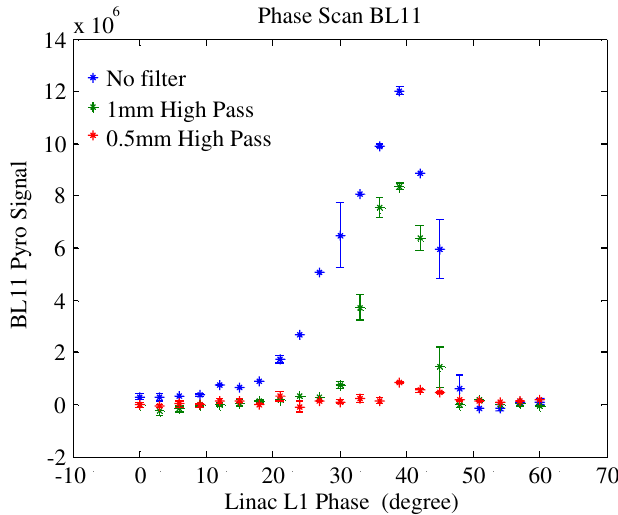
FIG. 25. (Color) Response of pyroelectric detectors (arbitrary scale) as a function of the L1S rf phase (rf section before BC1). A phase of zero is on-crest and a positive phase compresses the bunch length. The plot is shown for: (1) no wavelength filter (blue), (2) a 0.5-mm high-pass filter (red), and (3) a 1-mm high- pass filter (green).